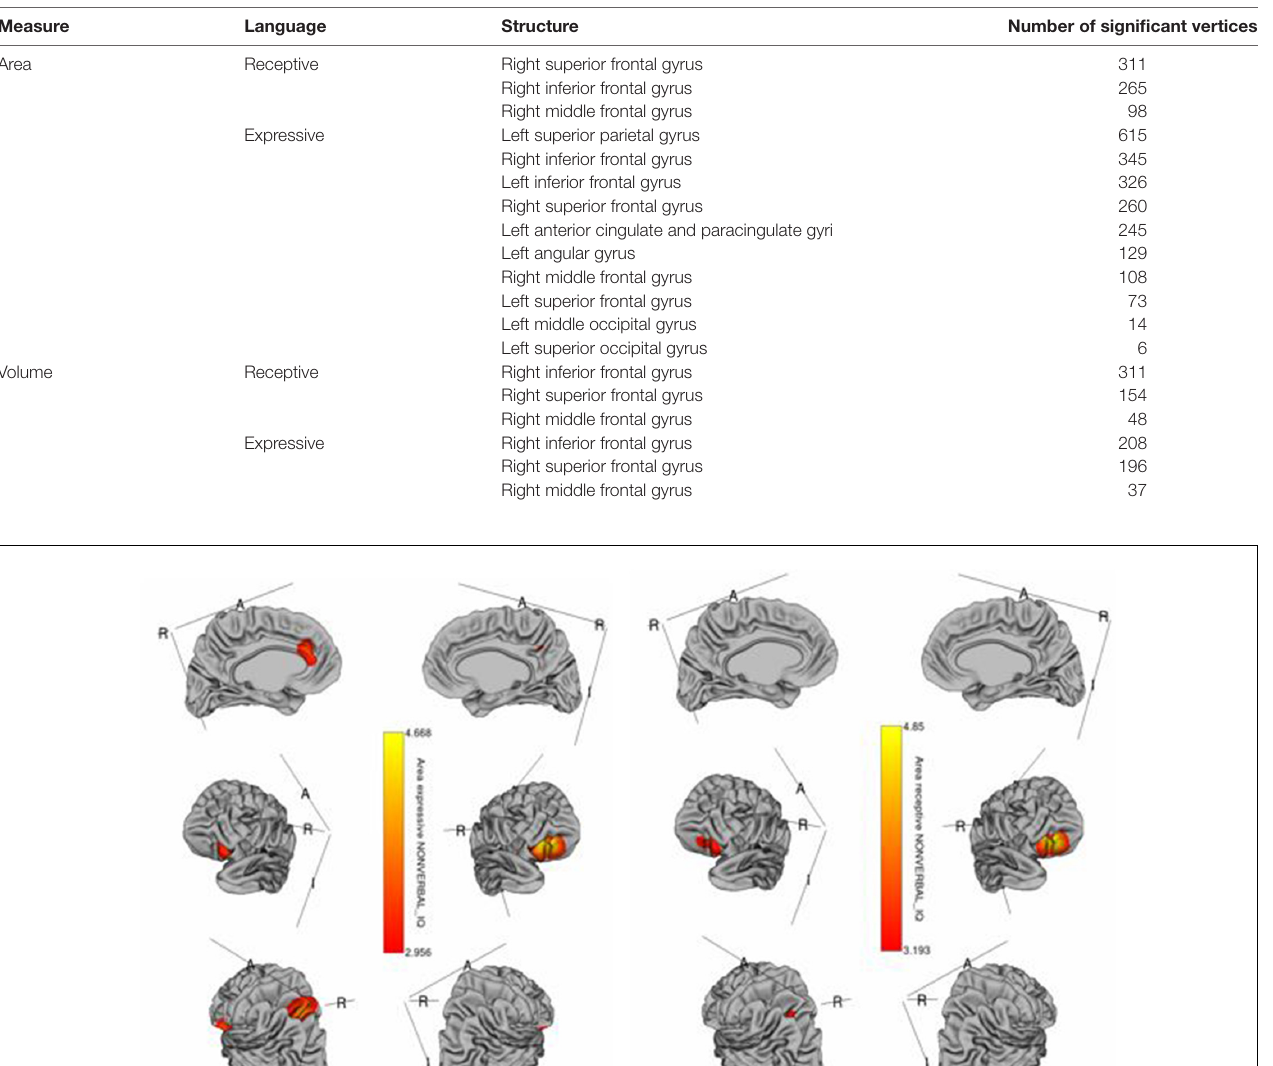
TABLE 4 | Area (mm 2 ) and volume (mm 3 ) of structures with significant vertices that predict expressive and receptive language abilities across diagnostic groups.